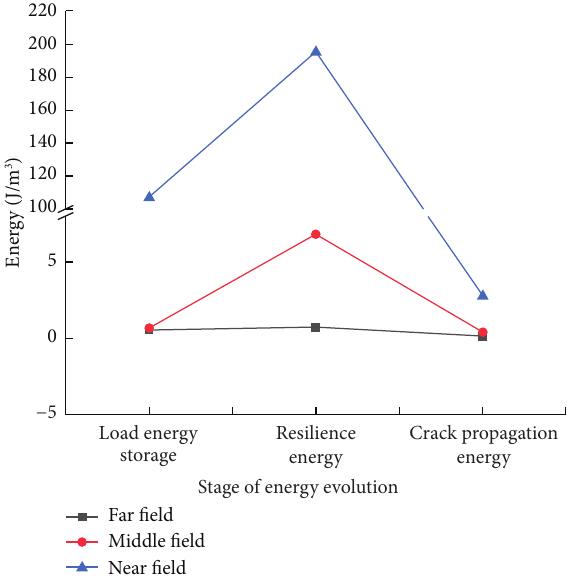
Figure 11: Energy characteristics of different